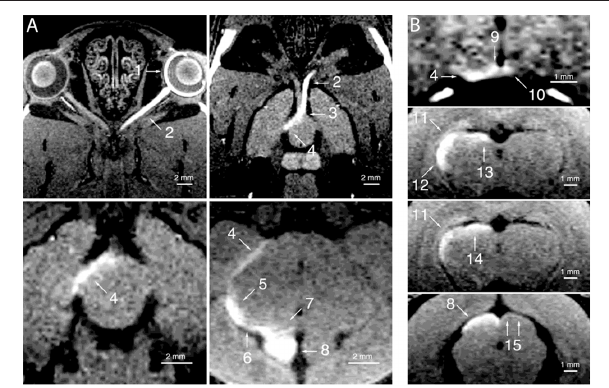
FIGURE 5 | Manganese enhanced tracing of the rat visual system. Adapted with permission from Watanabe et al. (2001). Enhancement of the visual pathway 24 h after intravitreal injection of manganese. Images were collected in the (A) horizontal and (B) coronal planes. 1 = left retina, 2 = left optic nerve, 3 = optic chiasm, 4 = right optic tract, 5 = right lateral geniculate nucleus, 6 = right brachium of the superior colliculus, 7 = right pretectal region, 8 = right superior colliculus, 9 = right suprachiasmatic nucleus, 10 = left suprachiasmatic nucleus, 11 = right dorsal geniculate nucleus, 12 = right ventral lateral geniculate nucleus, 13 = right olivary pretectal nucleus, 14 = right nucleus of the optic tract, 15 = superficial part of the superficial gray layer of the left superior